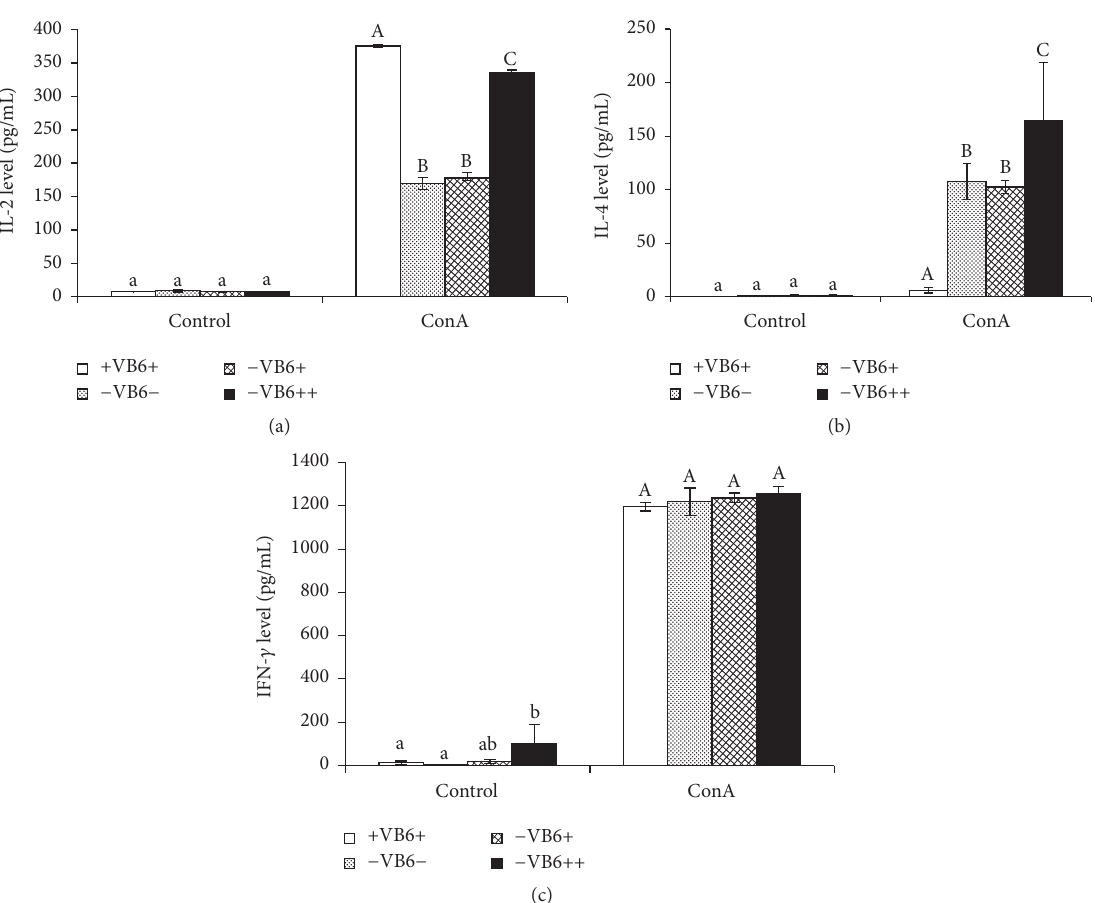
Figure 4: Cytokines IL-2 (a), IL-4 (b), and IFN- 𝛾 (c) secretion level of different vitamin B6 diet mice splenocytes after ConA stimulation. 5 𝜇 g/mL ConA was added to stimulate the splenocyte, while the control received the same volume of RMPI1640 medium. After 48 h of incubation, cytokine levels in the culture medium were measured by ELISA method. Each column represents the mean ± SD of seven replications with three independent experiments. Columns marked with different letters are significantly different ( 𝑃 < 0.05 ) among different diet